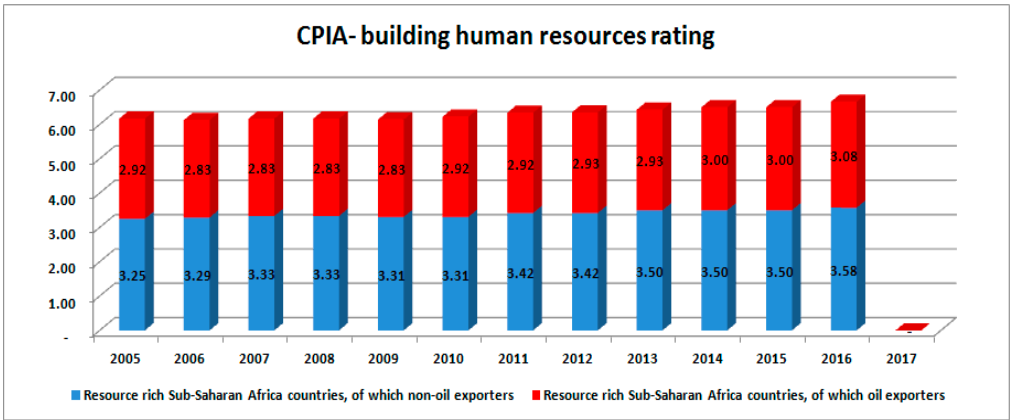
Figure 8. Country policy and institutional assessment: building human resources rating.